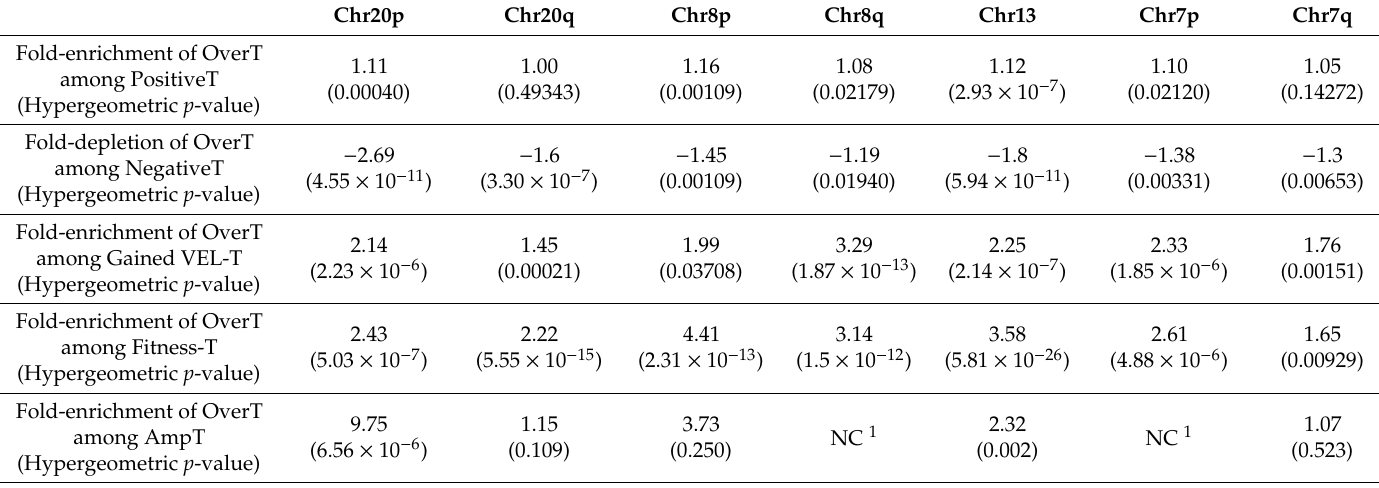
Table 1. Fold-enrichment of OverT among di ff erent classes of transcripts evaluated by hypergeometric